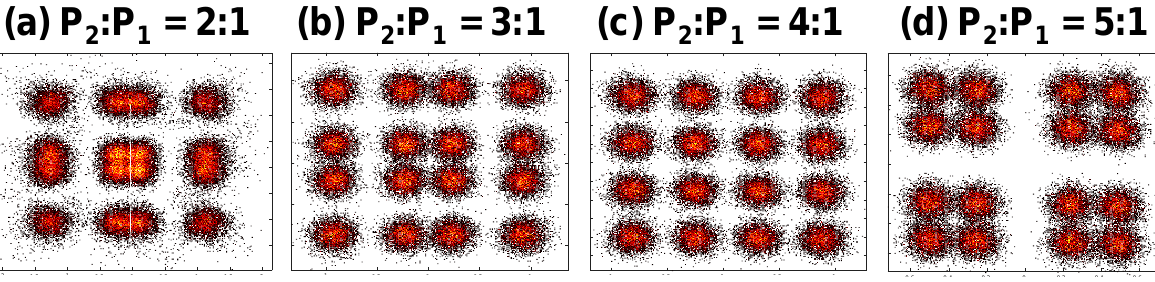
Figure 7. Experimental constellation diagrams of the power domain combined Data 1 and Data 2 OFDM-NOMA signals at different power ratios using BPSK.